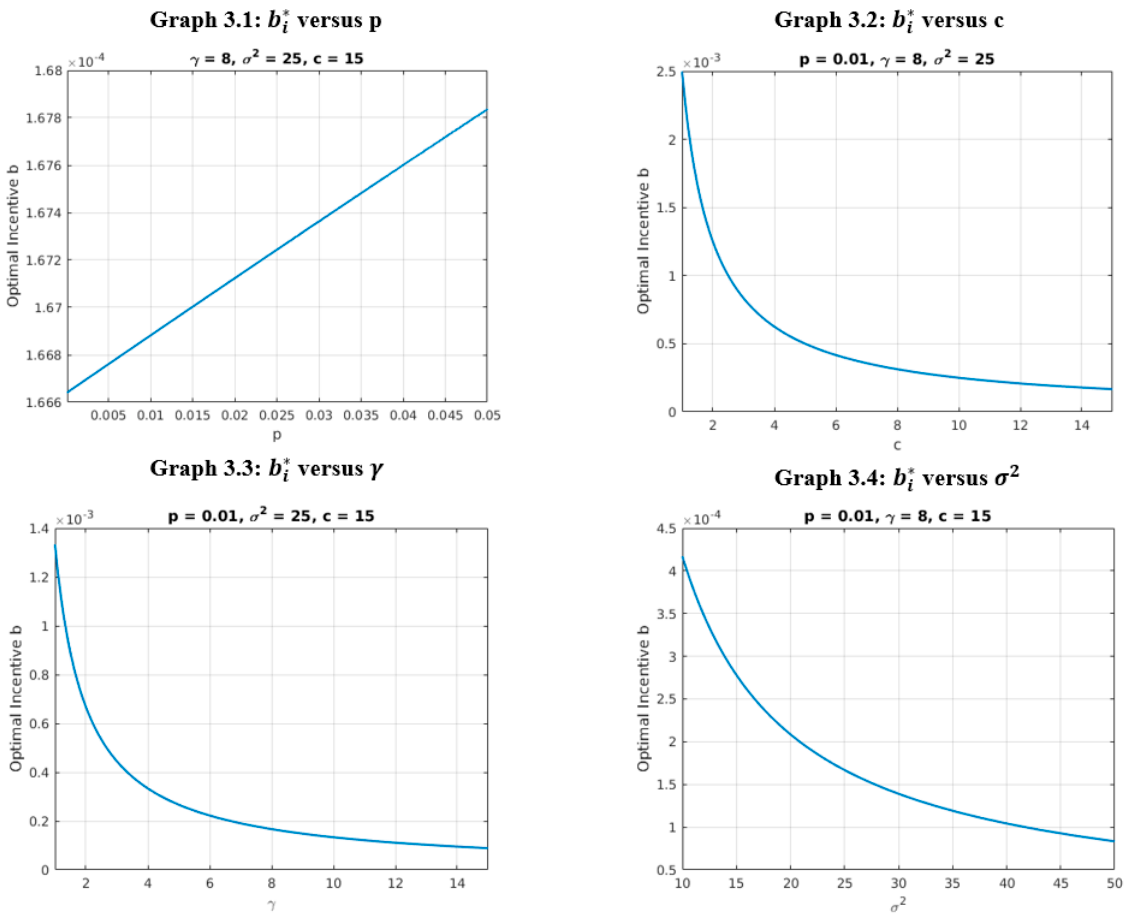
Figure 3. Comparative static analysis on the optimal incentive 𝑏 (cid:3036)∗ , after endogenizing N .